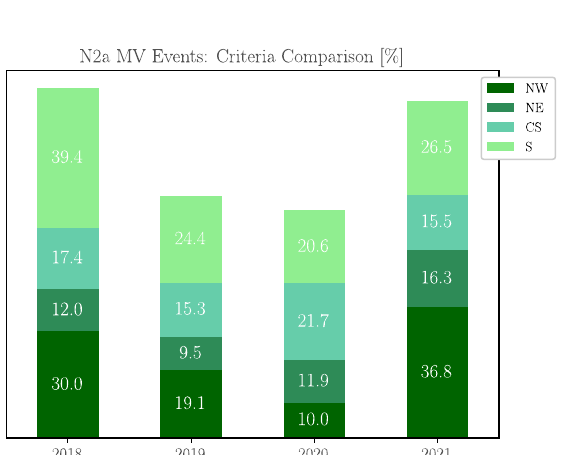
Table 12. N3b comparison: overall